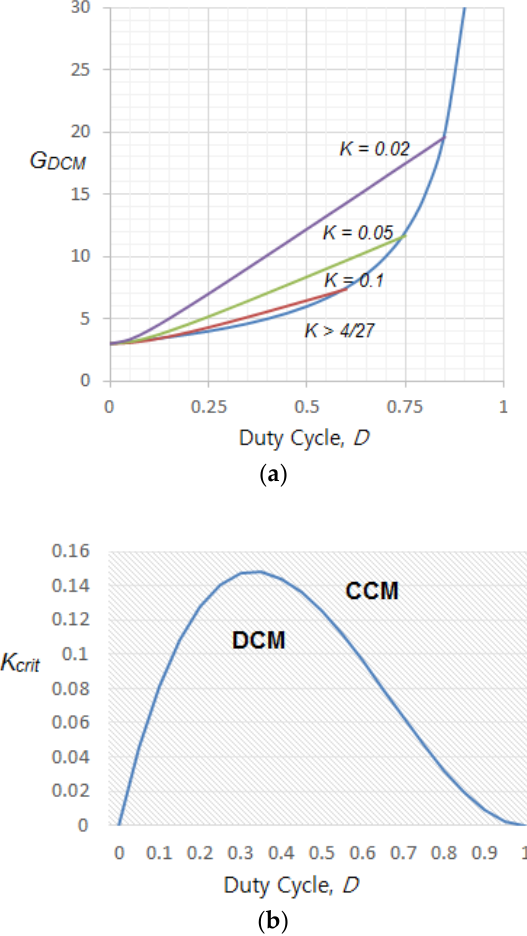
Figure 6. Curves in DCM/CCM operation. ( a ) Voltage gain of the proposed SC converter in DCM/CCM; ( b ) K crit and D at the CCM/DCM boundary.